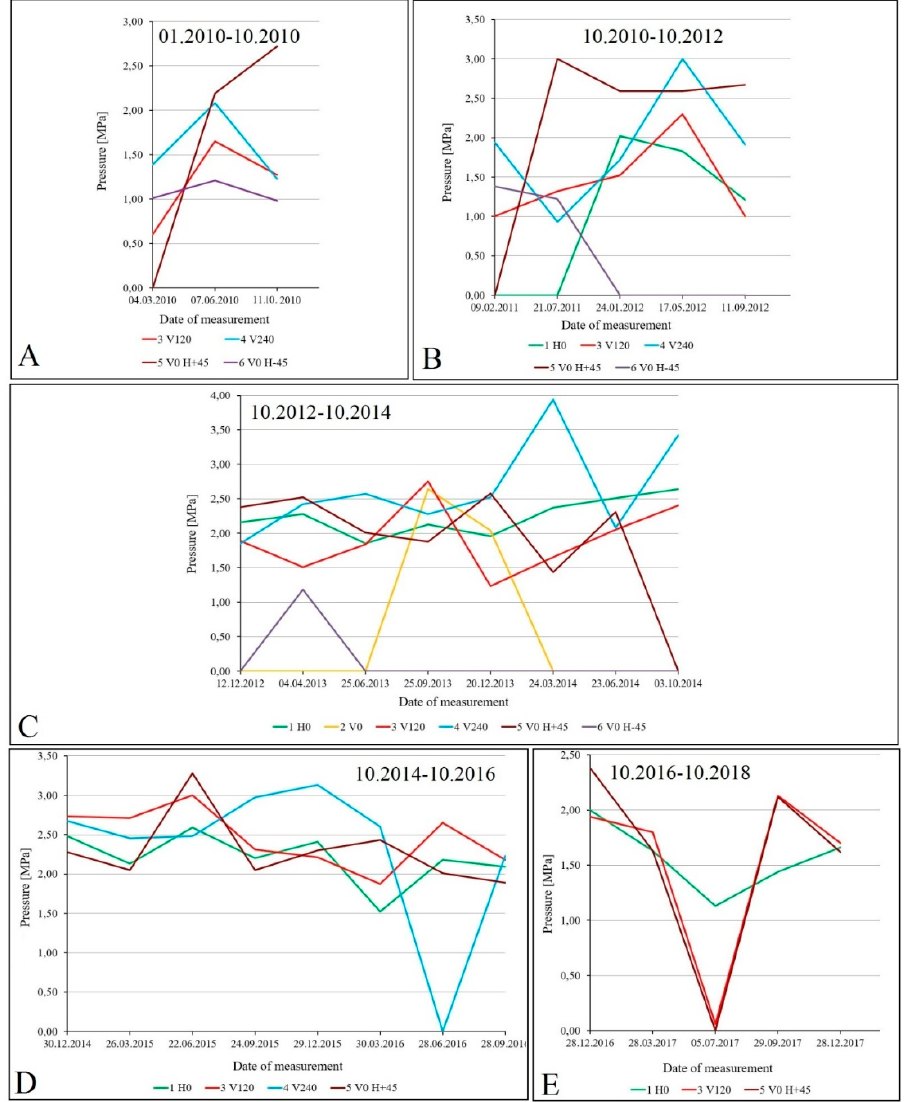
Figure 13. The pressure registered by the AWID pads in each period.